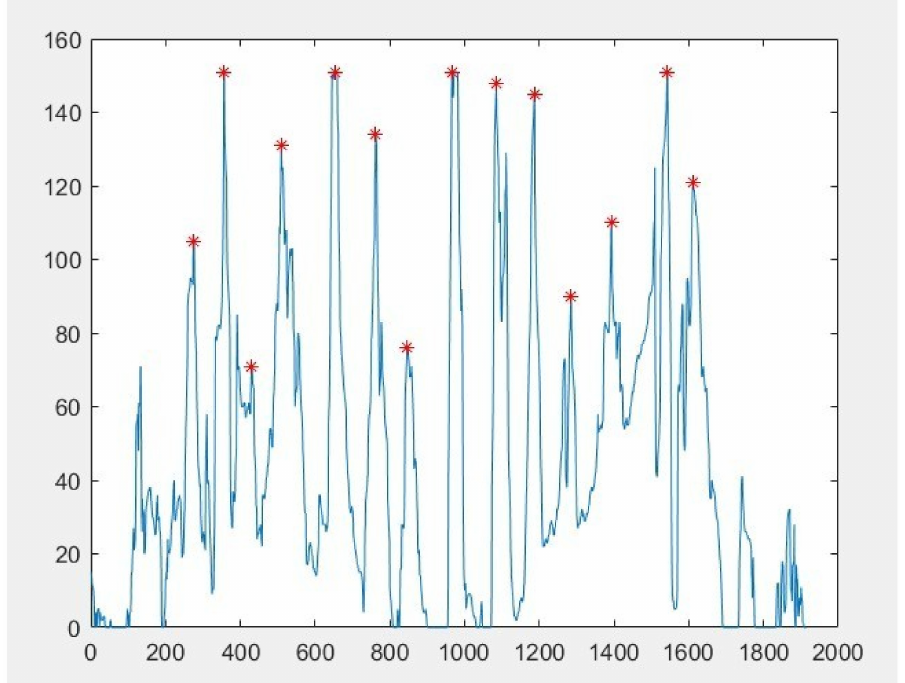
Figure 16. Line graph of the Gaussian filtering.